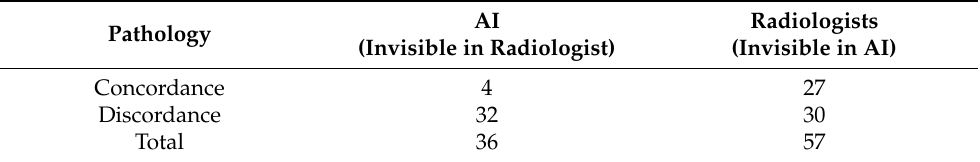
Table 5. Concordance of ‘invisible’ lesions between pathology results and radiologists’ analysis or AI analysis.